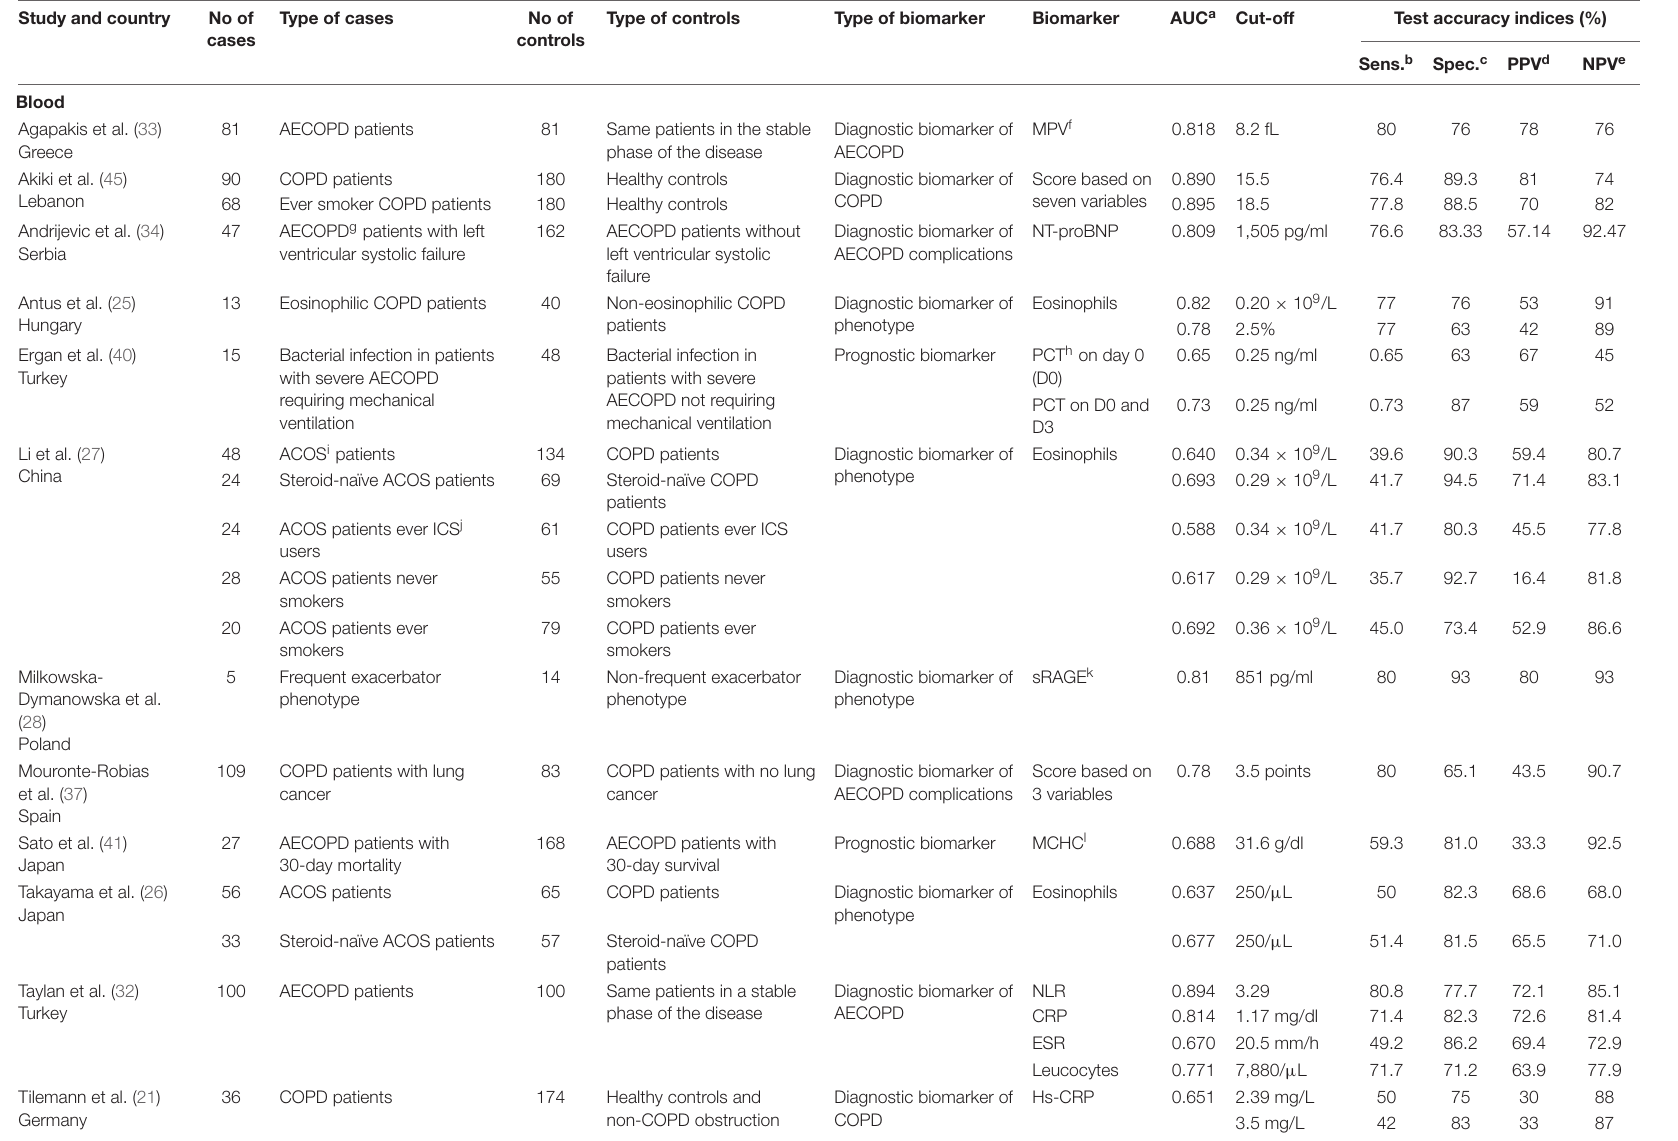
TABLE 1 | Diagnostic accuracies of liquid biomarkers for chronic obstructive pulmonary disease (COPD). Study and